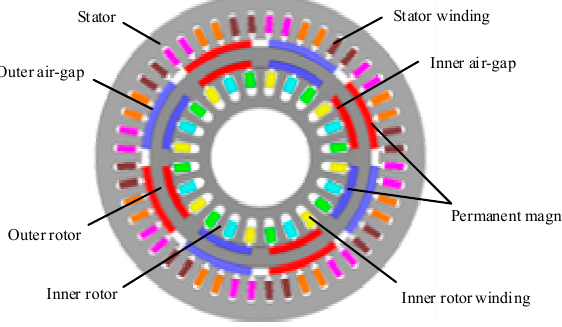
Figure 13. FEM model of CSPM Motor.